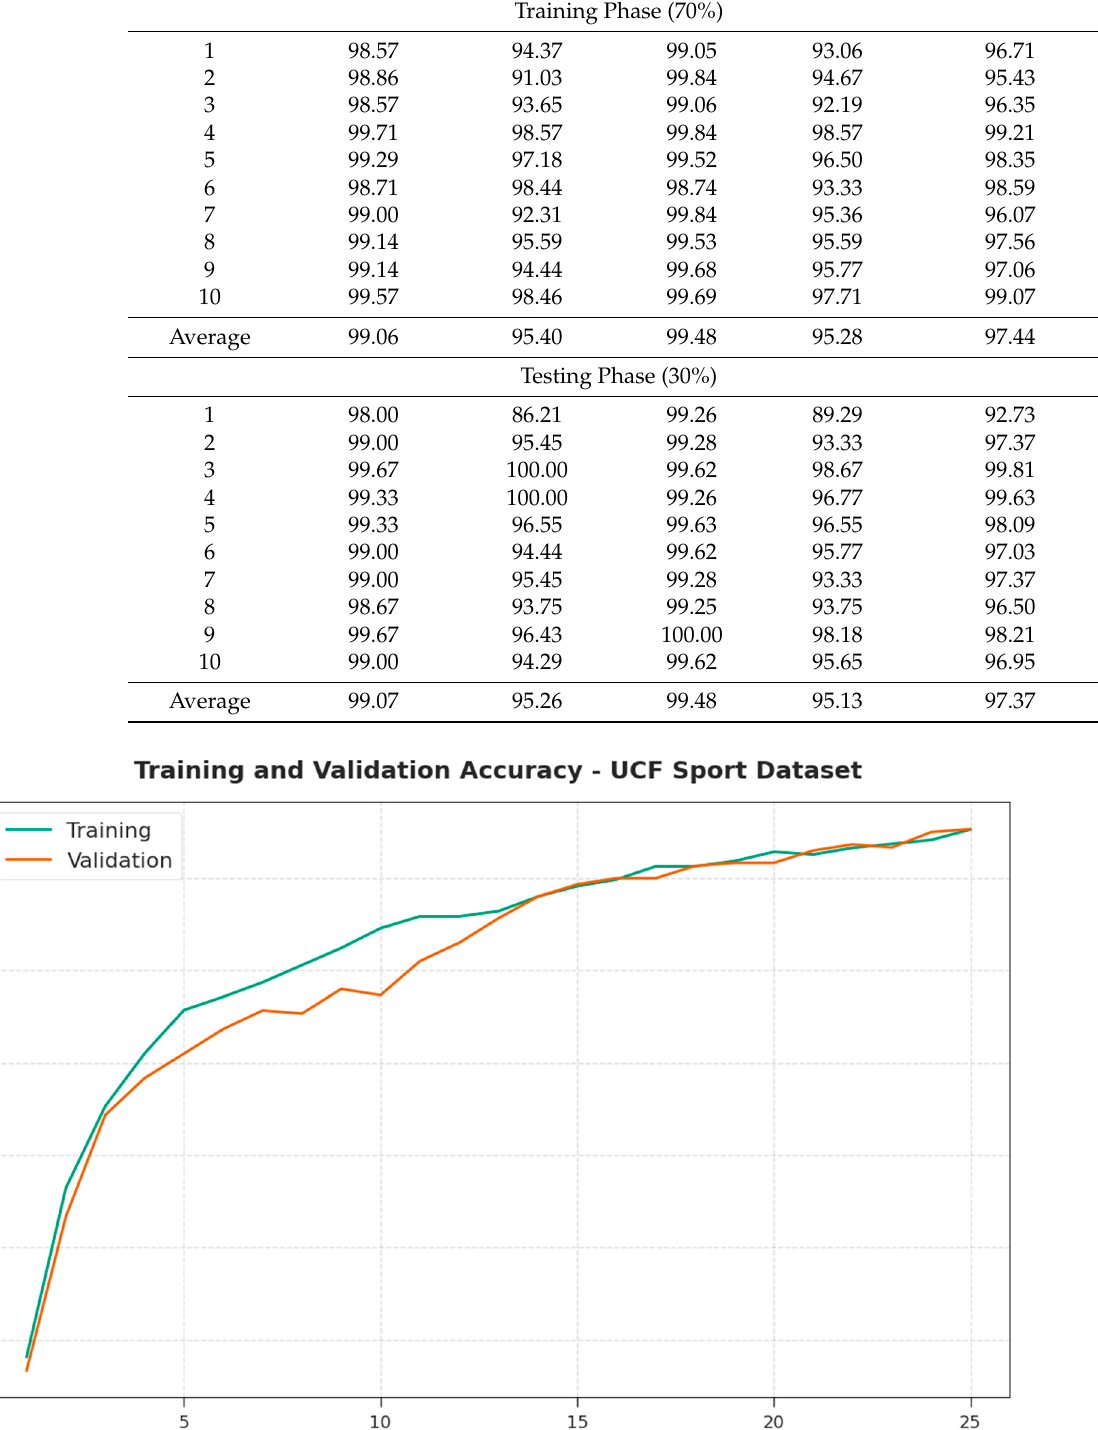
Figure 8. Training and validation accuracies of QWSA-HDLAR model on KTH dataset. In order to report the enhanced performance of the QWSA-HDLAR technique, a com- parison study with recent methodologies [28,29] is performed on the UCF Sports dataset